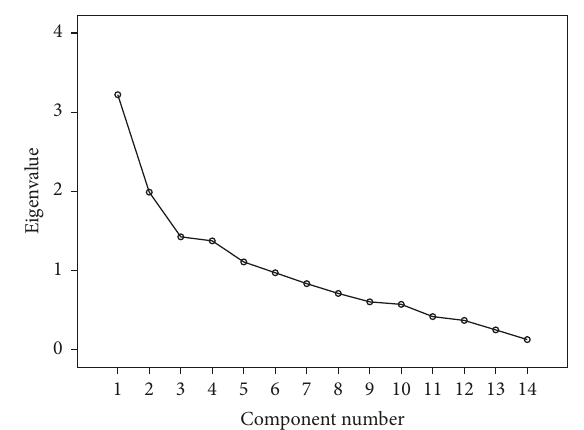
Figure 2: Scree plot for knowledge domain: construct